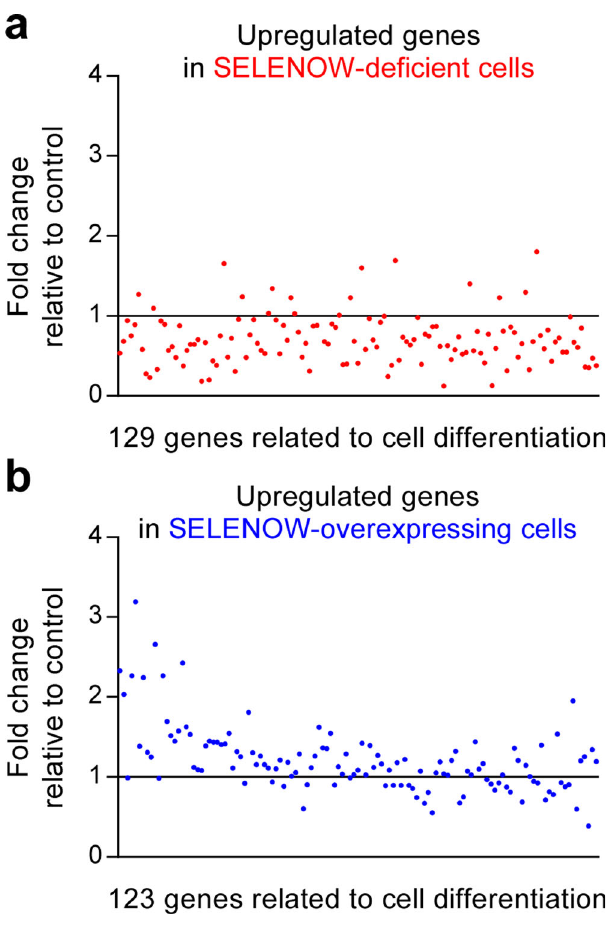
Fig. 5 SELENOW upregulates osteoclast differentiation-related genes. a , b Analysis of RNA-sequencing transcriptomic data. Osteoclast precursors from SELENOW − / − and SELENOW -transgenic mice and corresponding wild-type littermates were differentiated into osteoclasts in the presence of M-CSF and RANKL for 3 days. The relative fold change in the levels of genes in SELENOW − / − ( a ) and SELENOW -overexpressing osteoclasts ( b ) was determined. Source data are provided as a Source Data fi